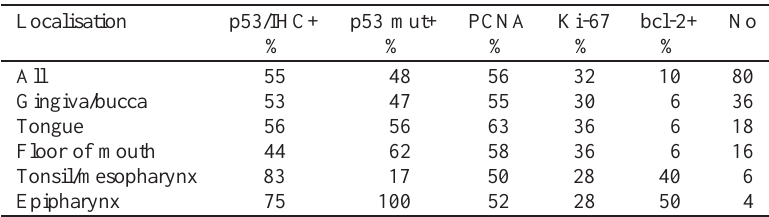
Table 2 Median values for the different parameters with respect to